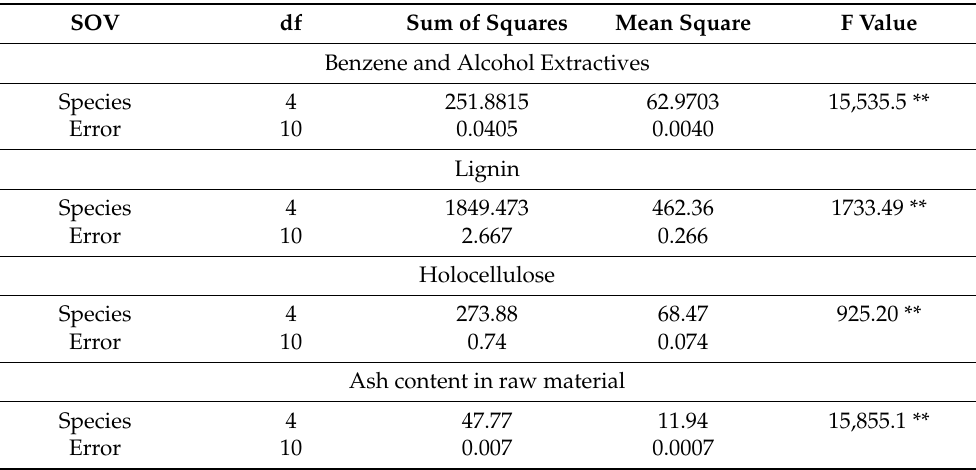
Table 1. ANOVA test for the chemical properties of raw materials. SOV df Sum of Squares Mean Square F Value Benzene and Alcohol Extractives Species 4 Error